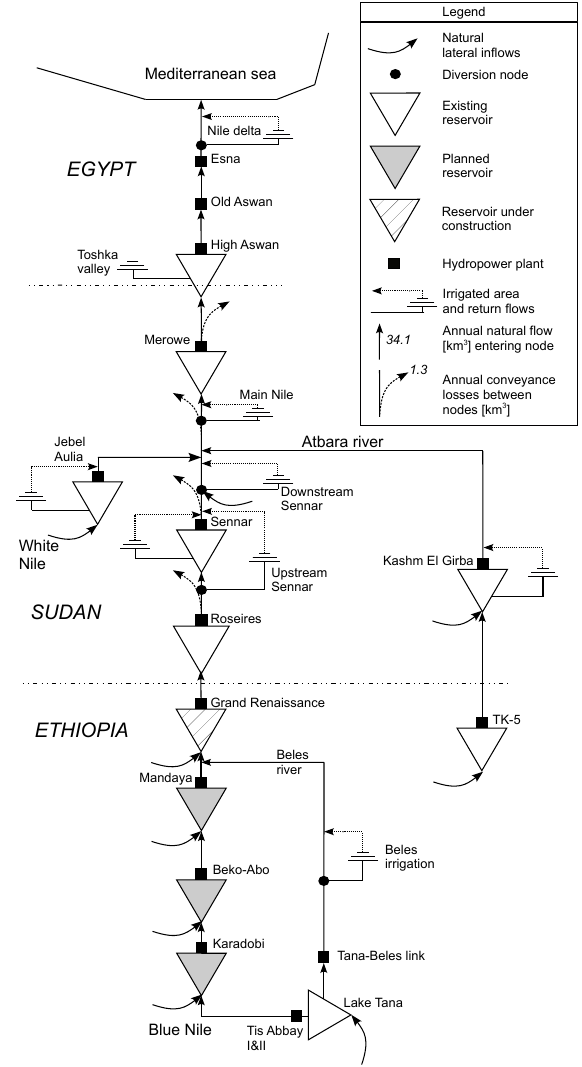
Figure 4. Schematization of the Eastern Nile River basin. (MW m − 3 s − 1 ) of the power stations which, in turn, is influ- enced by the topography (the unit productivity increases with the head on turbines and thus with the hydraulic gradient).